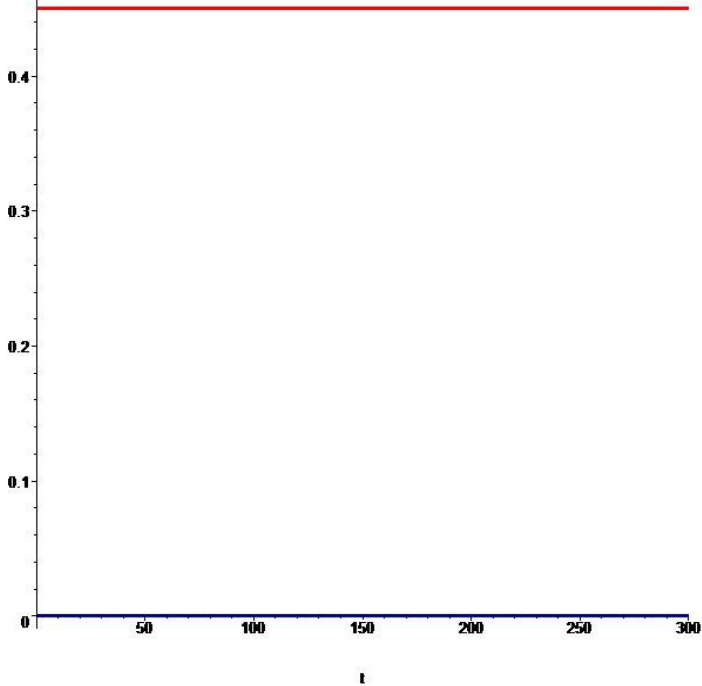
( t ) , v ( t ) for the Ebola outbreak in Liberia (2014) ∗ ∗